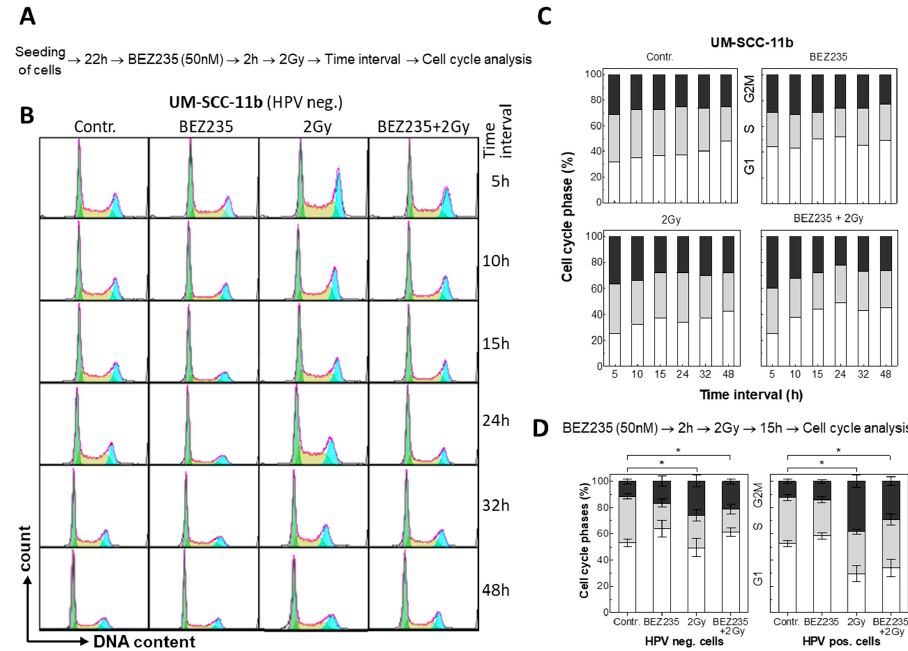
Figure 2. Effect of BEZ235 on cell cycle distribution in HPV neg. and pos. HNSCC cell lines; 22 h after seeding, cells were incubated with BEZ235 for 2 h prior to 2 Gy irradiation, followed by an incubation from 5 h to 48 h. Quantification of cell cycle distribution was performed by flow cytometry of propidium-iodide-stained cells. ( A ) Treatment schedule. ( B ) Cell cycle distribution of UM-SCC-11b cells as determined 5 h to 48 h after treatment. ( C ) Percentage of cell cycle phases of UM-SCC-11b cells taken from ( B ). ( D ) Summary of the cell cycle distribution of all five HPV neg. and pos. HNSCC cell lines as determined 15 h after treatment. Significant differences in G1 distribution between conditions are shown with asterisks ( p -value < 0.05).